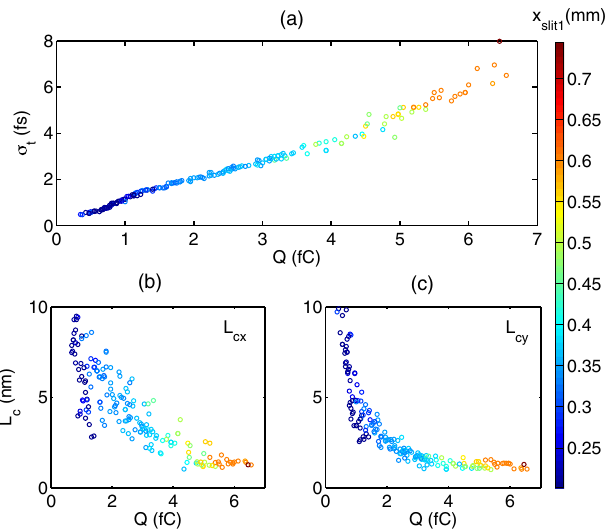
FIG. 5. Results of genetic optimization using the GPT code. (a) Optimized configurations after convergence of the algorithm showing the rms duration of the bunch σ t versus its charge Q . (b) and (c) show the coherence lengths L cx and L cy versus charge for optimized configurations of the beam line. The color scheme represents the opening along x of the first slit in the beam line.